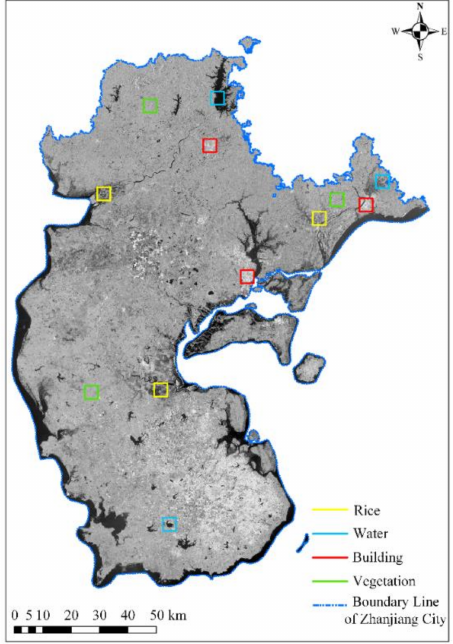
Figure 3. Distribution diagram of sample areas for statistical characteristic analysis.